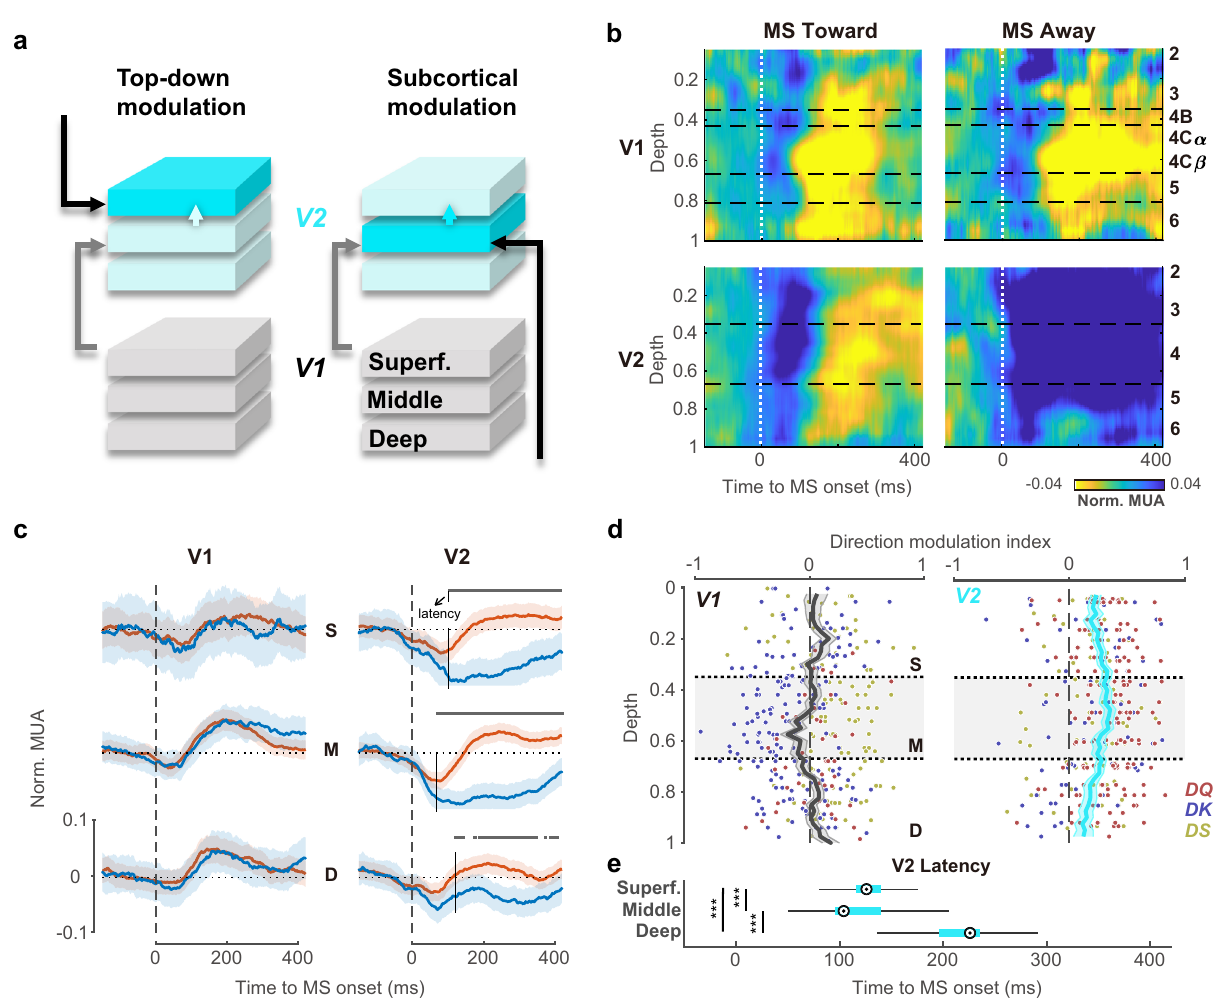
Fig. 4 | Laminarpro fi leofmicrosaccade modulationin V1 and V2. a Schematics of laminar circuits based on two hypotheses. Left panel, top-down modulation targets on the super fi cial layer in V2, shown by the black arrow. Feedforward connections from V1 super fi cial layer targets on the middle layer of V2 (the gray arrow) and interlayer feedforward connections from the middle layer to the super fi ciallayer(the grayarrow).If DSMMisfrom the high-levelcortex, the DSMM would fi rst appear in the super fi cial layer in V2 (marked in dark blue). Right panel, subcorticalconnections target the middlelayer of V2(the blackarrow). If DSMMis from a subcortical region, DSMM would fi rst appear in the middle layer in V2 (markedindarkblue). b Laminarpatternofmicrosaccadedynamicsaveragedfrom multipleprobelocationsinV1( N =23) and V2( N =32).MUAresponsestrength was coded by color. c Left, normalized MUA (mean±s.e.) in V1 around microsaccade onset in the super fi cial layer (top), middle layer (middle) and deep layer (bottom). The toward condition is marked in orange, and the away condition is marked in